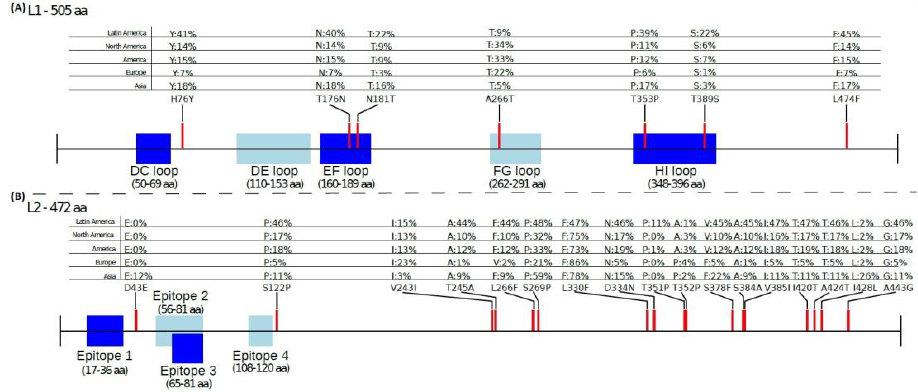
Figure 2. Mutation profile of HPV16 L1 and L2 proteins. The immunogenic regions of viral proteins are highlighted. ( A ) Seven amino acid mutations were detected in the L1 protein with high frequency in cer- tain geographic areas. Five of these mutations (T176N, N181T, T266A, T353P, T389S) are located within the L1 hypervariable surface loops. ( B ) Seventeen amino acid mutations were found in the L2 protein with high frequency in various geographic populations. Two of these amino acid substitutions (D43E, S122P) are adjacent to the L2 specific epitopes.